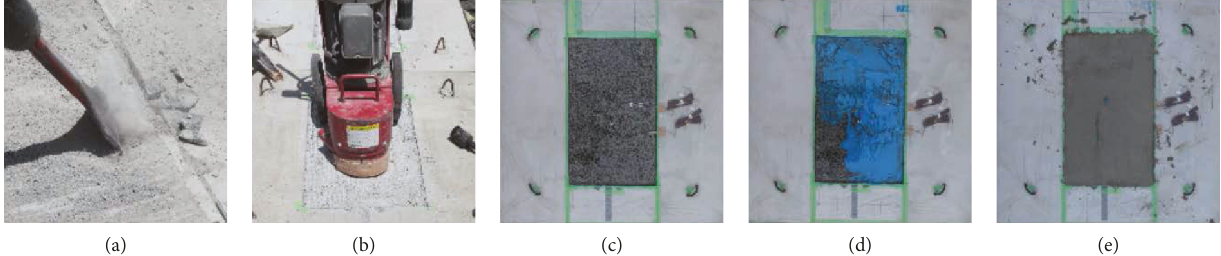
Figure 6: Procedure for manufacturing the RC slab specimen. (a) Removal of damaged parts. (b) Grinding of damaged parts. (c) Application of penetratable adhesive. (d) Application of bonding agent for placing. (e) Placing repair material and fi nish. Table 6: The number of equivalent cycles and the reinforced equivalent running number